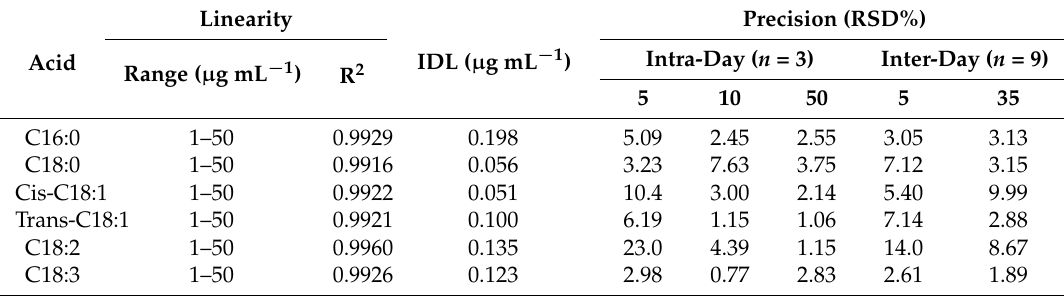
Table 4. Linearity, instrumental limits of detection, and precision of the GC-MS/MS method (intra-day at 5, 10, and 50 µ g mL − 1 , inter-day at 5 and 35 µ g mL − 1